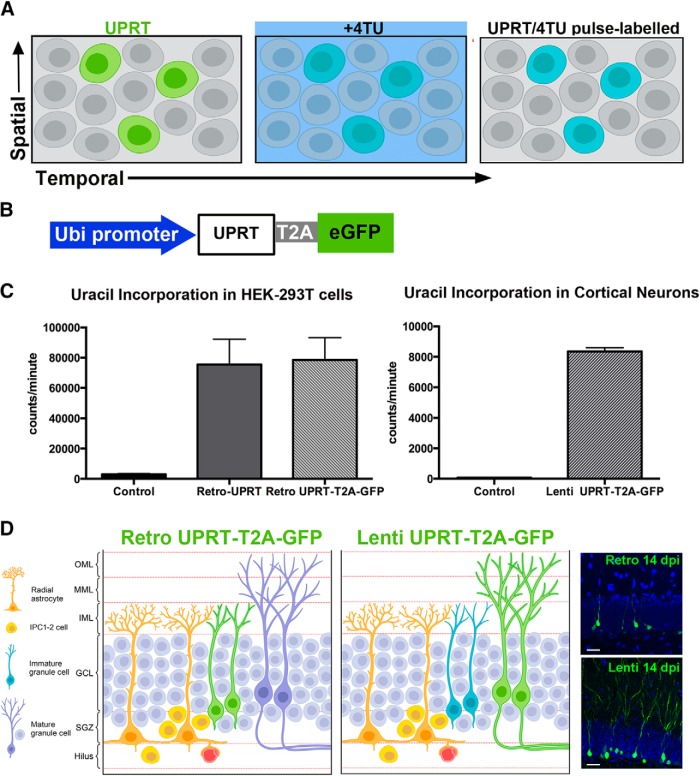
TU tagging in the adult DG. A, Overview of TU-tagging method: UPRT cell type specificity confers spatial control (green), and pulse chase of 4-TU provides temporal control (blue). B, Construct for virus-mediated UPRT expression. C, Uracil was incorporated in HEK-293 T cells transduced with UPRT-expressing retroviruses (left) and in neonatal hippocampal neurons transduced UPRT-expressing lentivirus (right). Data are plotted as the mean ± SD. D, Schematic of strategy for TU tagging of immature newborn and mature neurons with UPRT-expressing retroviruses and lentiviruses, respectively, in the adult DG (left and middle). Representative images of newborn and mature neurons that robustly express UPRT-T2A-GFP retrovirus (right top) and lentivirus (right bottom) at 14 DPI. Scale bar, 20 μm.